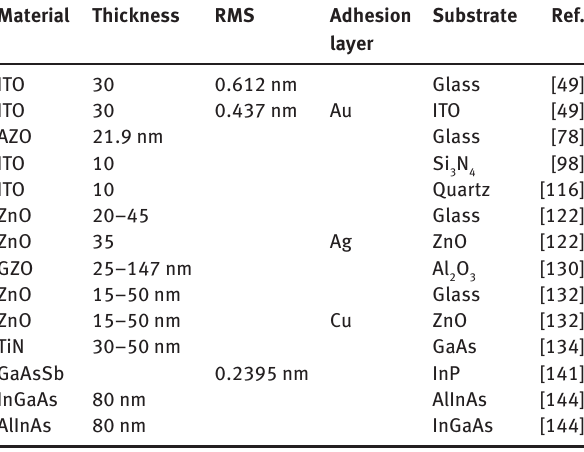
Table 4: Alternative material film parameters on different substrates and using various adhesion